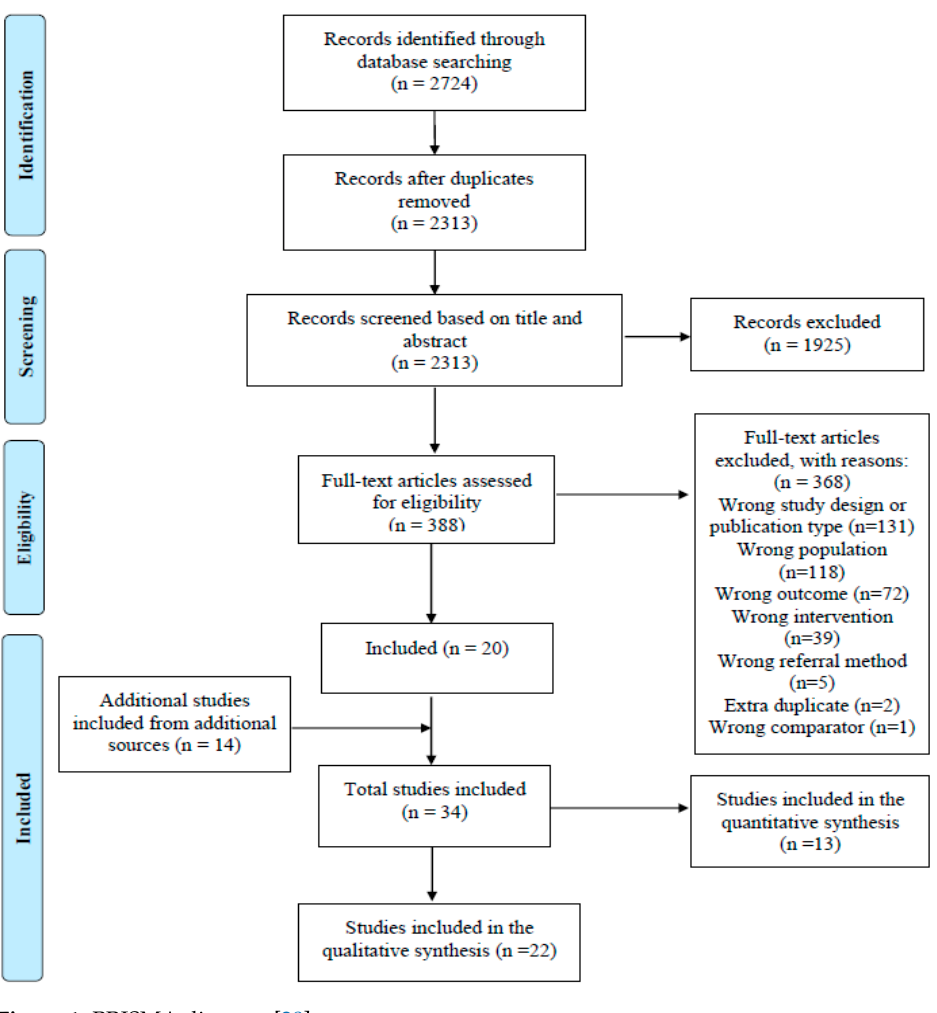
Figure 1. PRISMA diagram [28].